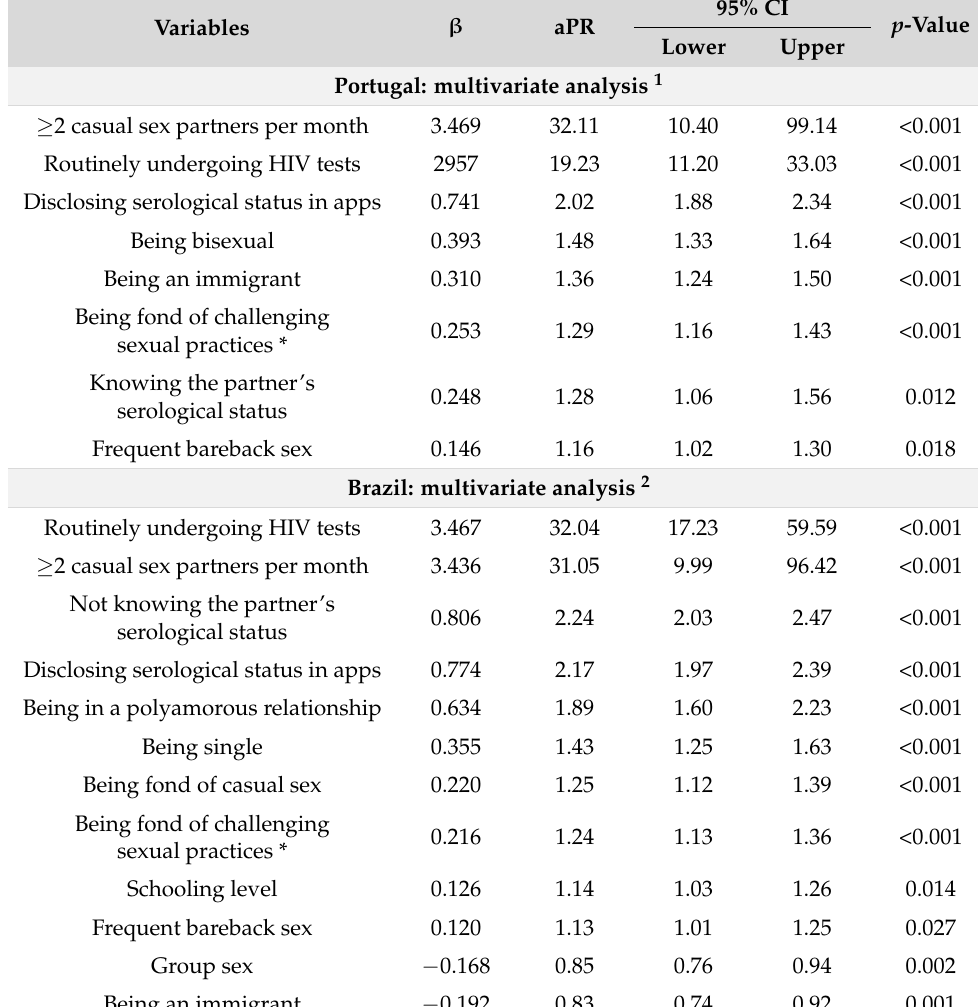
95% CI p -Value Lower Upper